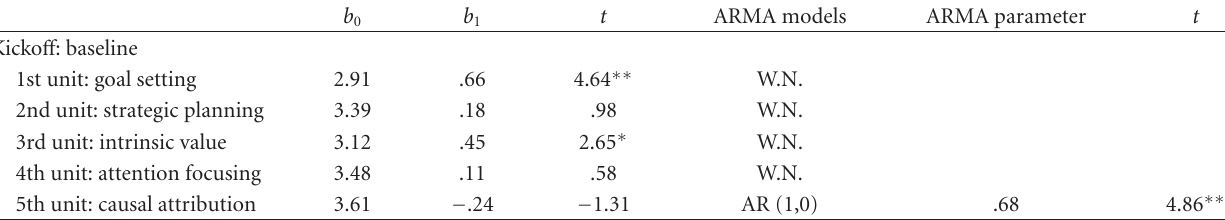
Table 7: Results of the interruption time series analysis to examine the e ff ects of the intervention.